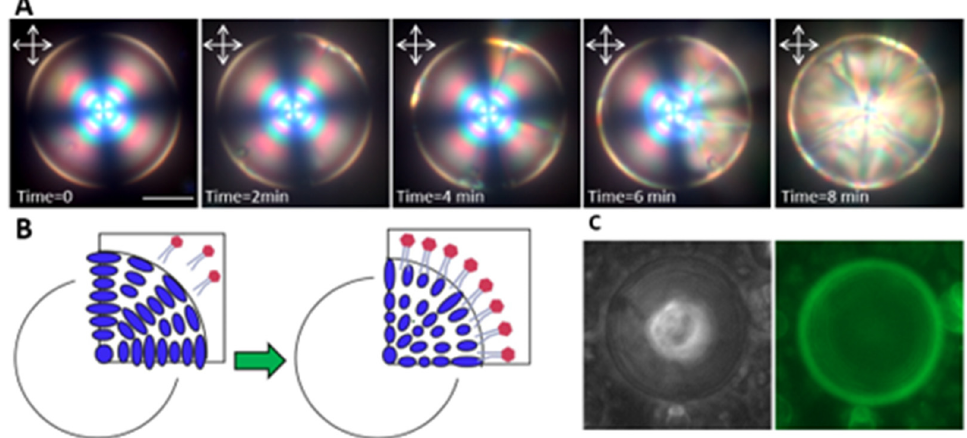
Figure 1. Reconfiguration of high-chirality LC droplets in the presence of DLPC amphiphiles. ( A ) Reflection mode POM images of reconfiguration dynamics in 30 µm high-chirality droplets in the presence of 0.5 mM DLPC. ( B ) Schematic of the planar to homeotropic ordering transition. ( C ) Bright-field and fluorescent image of adsorbed labeled DLPC amphiphiles on the chiral droplet’s interface (scale bar = 20 µm).